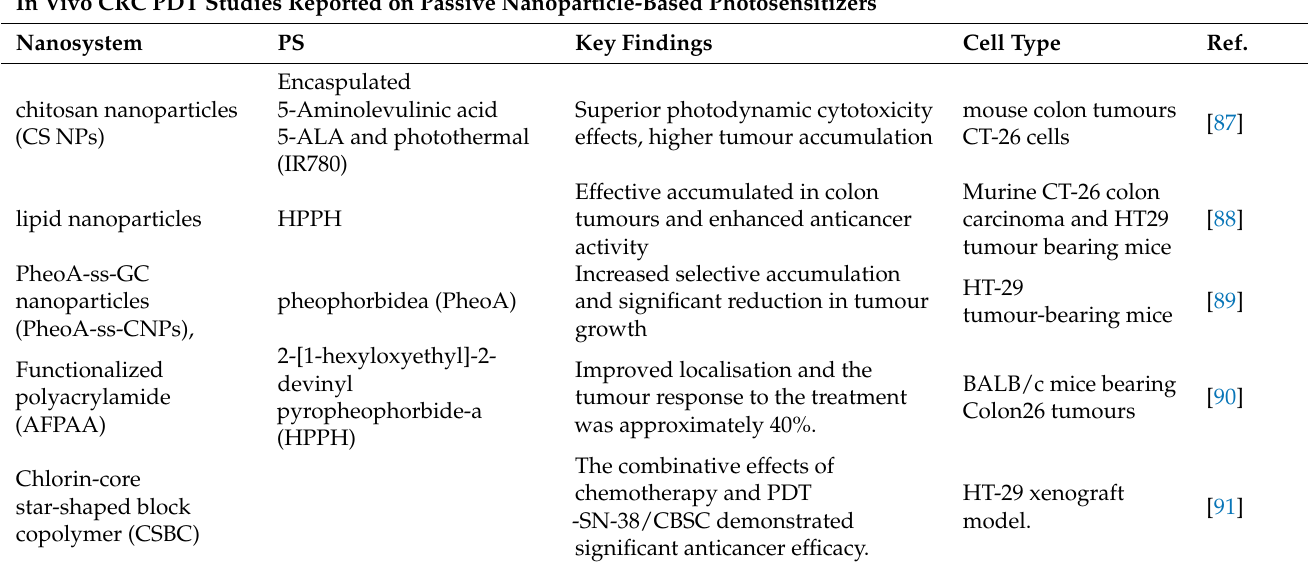
Table 2. Summary of in vivo studies PDT of passive NP-based PS delivery systems in CRC PDT treatment. In Vivo CRC PDT Studies Reported on Passive Nanoparticle-Based Photosensitizers Nanosystem PS Key Findings Cell Type